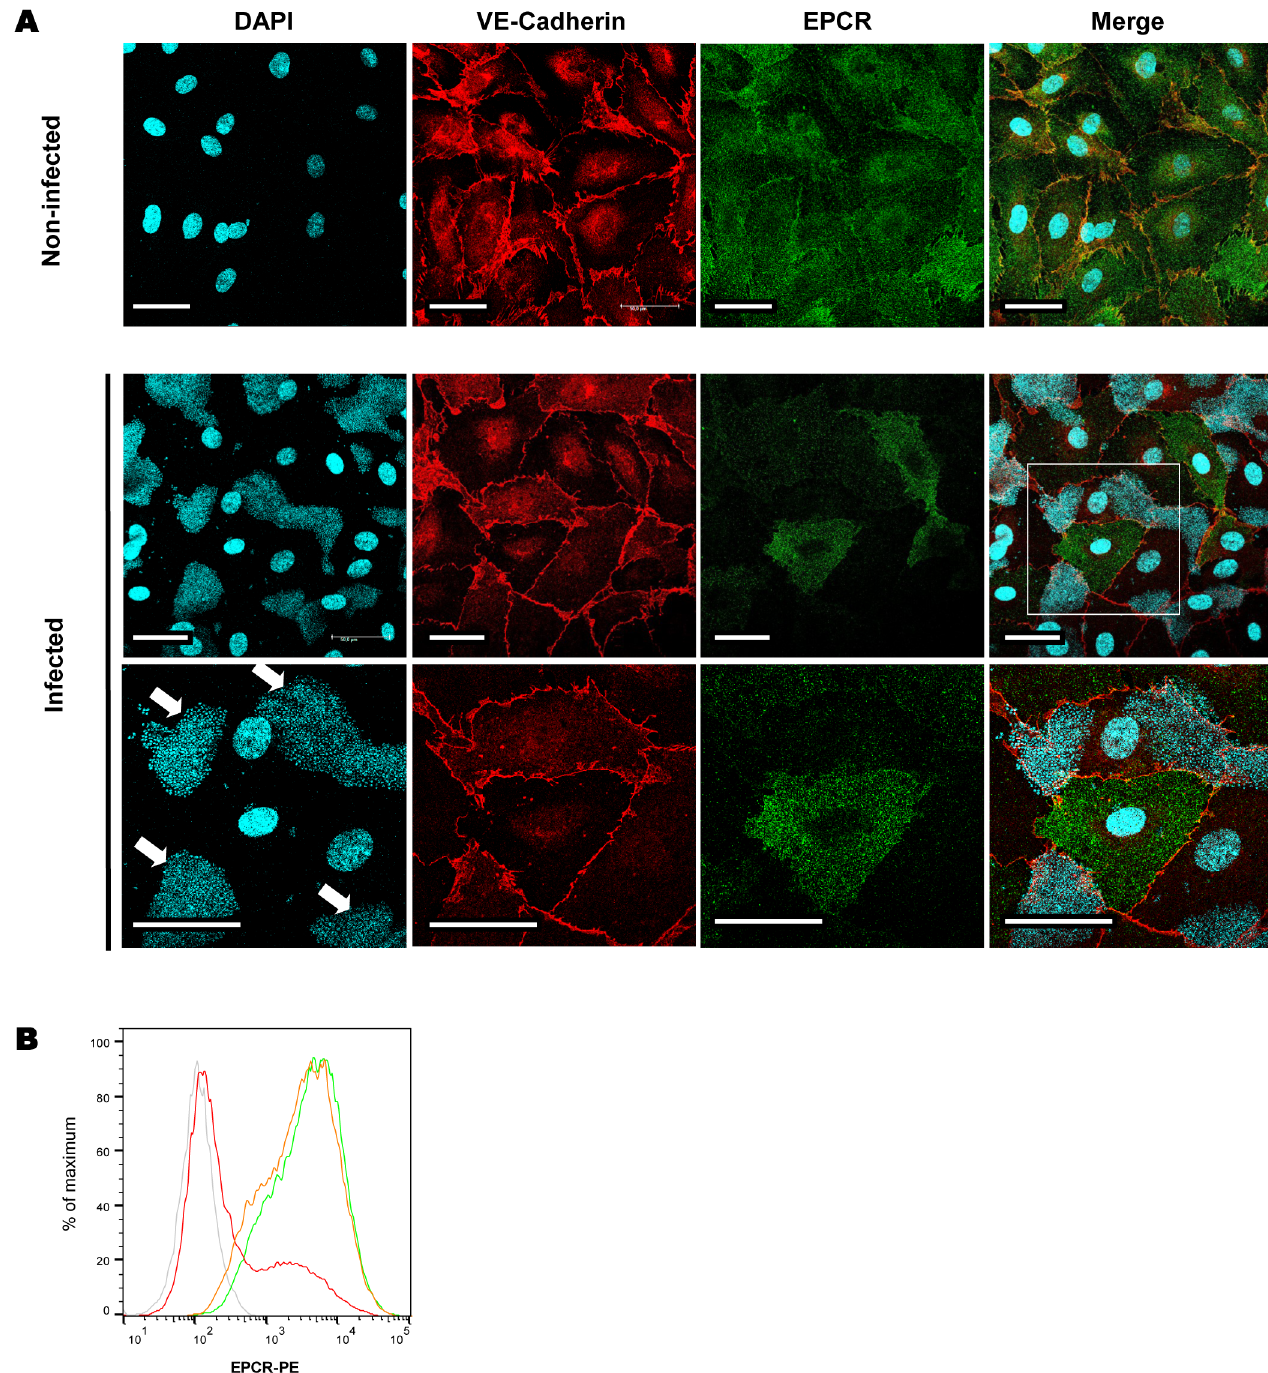
Fig 2. Meningococcal adhesion on endothelial cells is required to decrease EPCR expression. (A) HDMEC cells were left non-infected or were infected for 4h with a WT strain. DNA (cyan), junctionnal VE-Cadherin (red), or membranous EPCR (green) were stained using appropriate antibodies or DAPI. Bacteria were also stained using DAPI. Upper panel: non-infected cells. Medium panel: infected cells. Lower panel is a detailed view of the infected monolayer showing a non-infected cell surrounded by cells with N . meningitidis microcolonies (arrows) on the apical side. Scale bar: 50 μ M. (B) HDMEC cells were infected for 4 hours with a WT piliated N . meningitidis strain (red) or a non-adherent non-piliated Δ pilE strain (orange) or left non-infected (green). EPCR expression was assessed by a FACS analysis. Data are representative of 3 independent experiments. (grey: isotype control). For the quantification of EPCR expression see supplemental data S1 Fig .